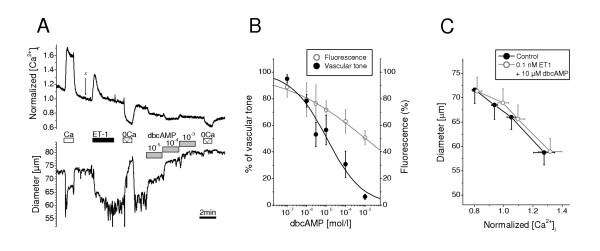
dbcAMP reverses ET-1 (1 nmol/L) -induced vasoconstriction in a dose-dependent manner. A) A representative recording of [Ca2+]i-diameter measurements. The [Ca2+]i was normalized to the value prior to application of ET-1 (value at timepoint "x" was set to 1.0). Maximal vasodilation was determined by exposure of the SMA to Ca-free conditions ("0Ca"). An increase of extracellular Ca2+ to 10 mmol/L ("Ca") induced a [Ca2+]i increase and parallel vasoconstriction. B) Dose-response curves of dbcAMP-induced vasodilation and [Ca2+]i decrease of ET-1 (1 nmol/L) preconstricted SMA. C) dbcAMP prevented ET-1-induced Ca2+-sensitization.